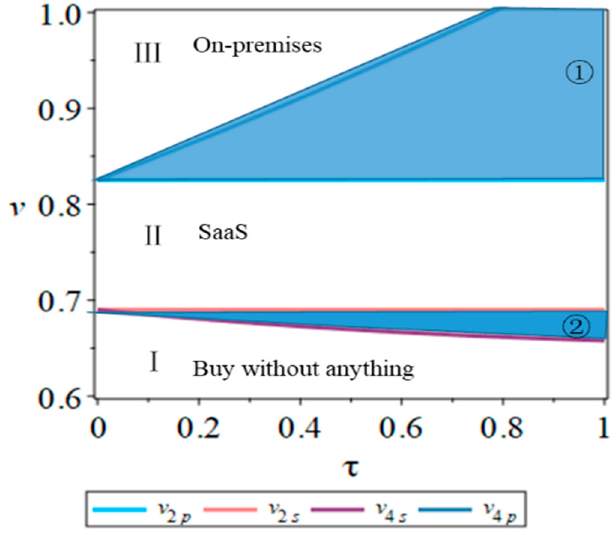
Figure 2. The distribution of users under the dual-product strategy ( δ = 0.1, k = 0.8; d = 0.2; c = 0.1; r p = 0.1; r s = 0.05; l = 0.1,